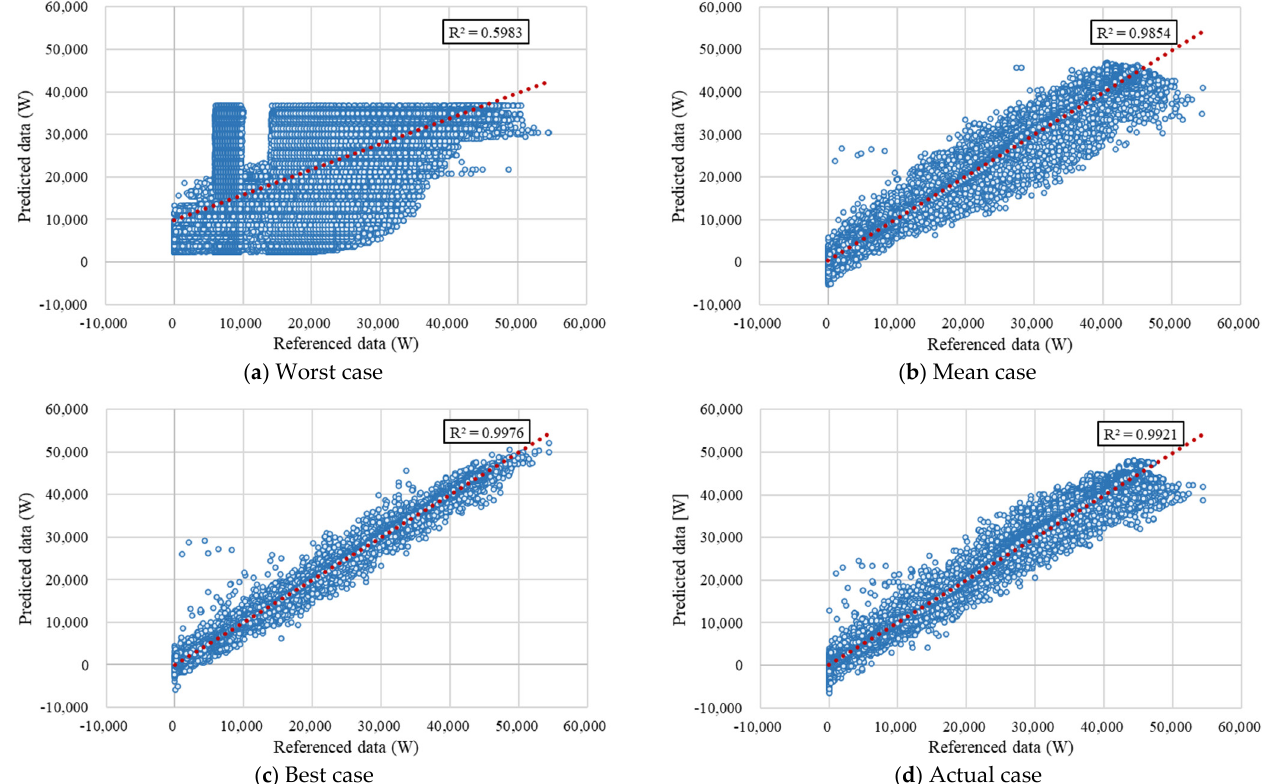
Figure 6. Comparison of heating loads (referenced data vs. predicted data).